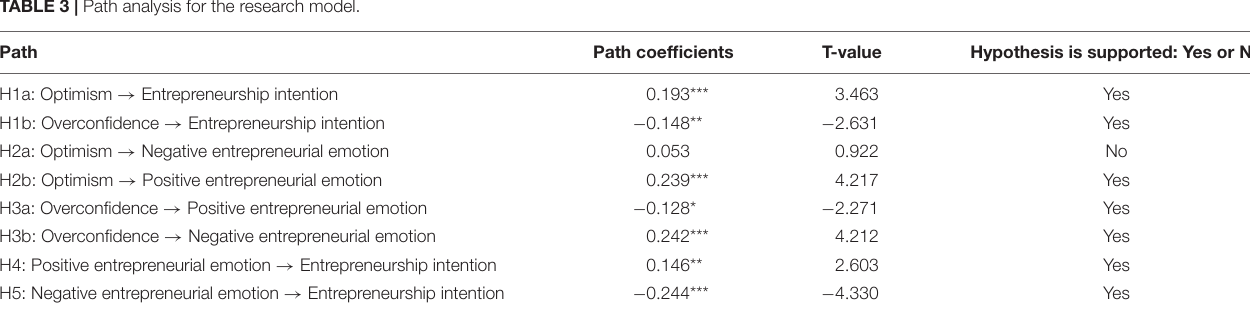
TABLE 3 | Path analysis for the research